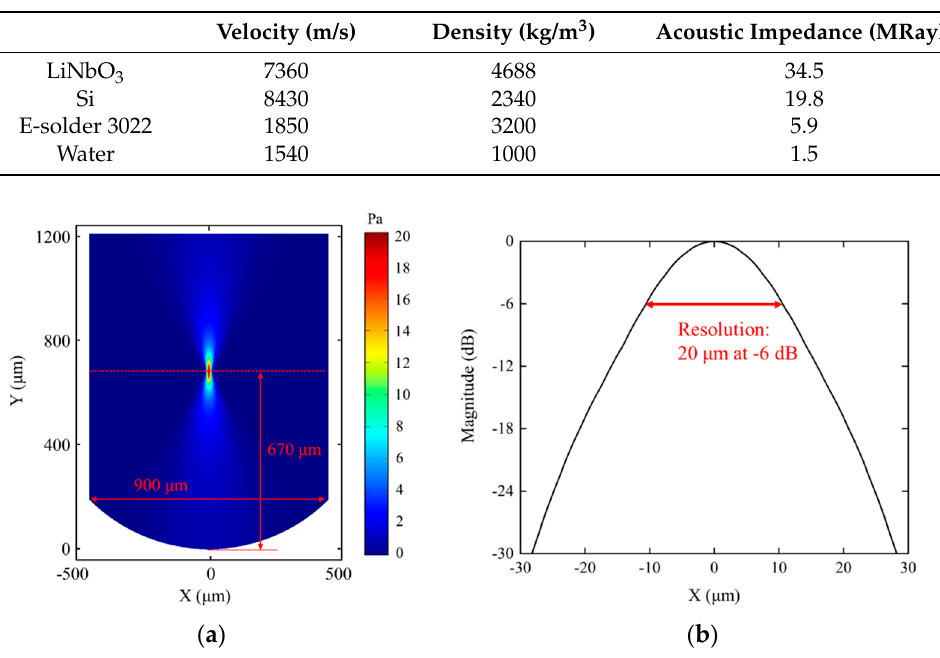
Figure 3. ( a ) The acoustic pressure field simulated by COMSOL. ( b ) The lateral resolution simulated by COMSOL. by Table 2. The parameters of materials in the COMSOL simulation.